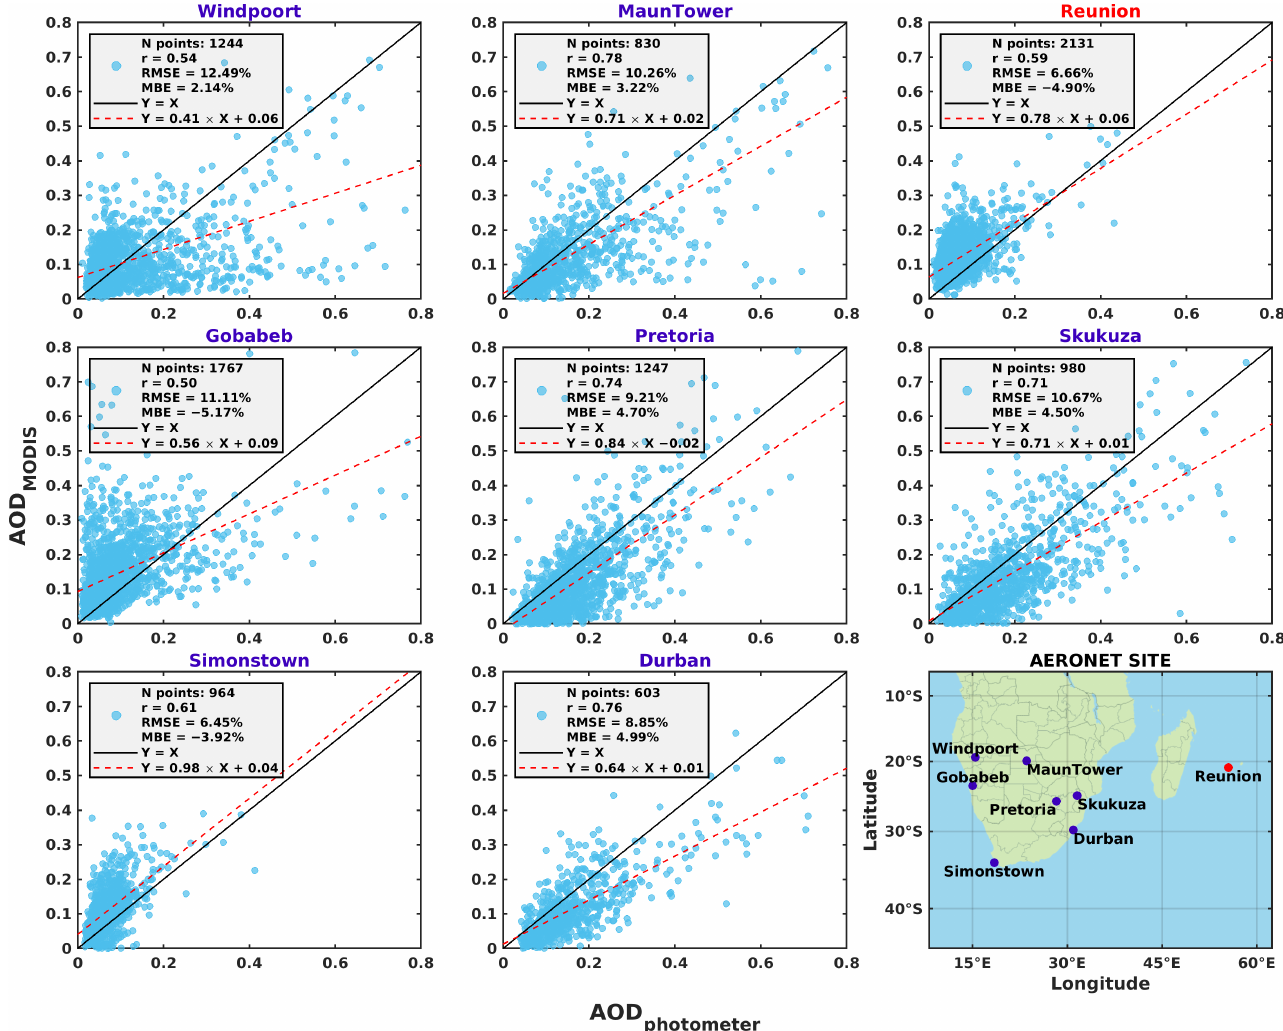
Figure 6. Scatter plot of AOD at 550 nm over the eight sun photometer sites. The total number of observations (N) for both instruments provided during the study period as well as the correla- tion coefficient (r), root mean square error (RMSE), mean bias error (MBE), and fitting curve (red lines). The black lines represent the 1:1 line. The bottom right panel represents the location of sun photometer